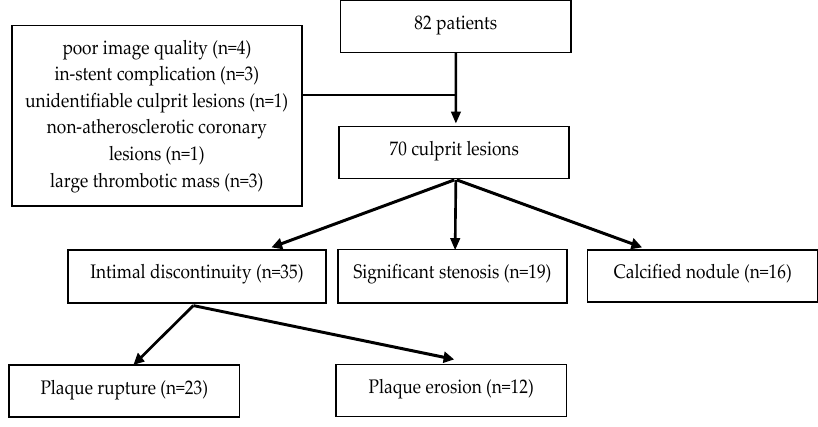
Figure 1. Patient flow chart.